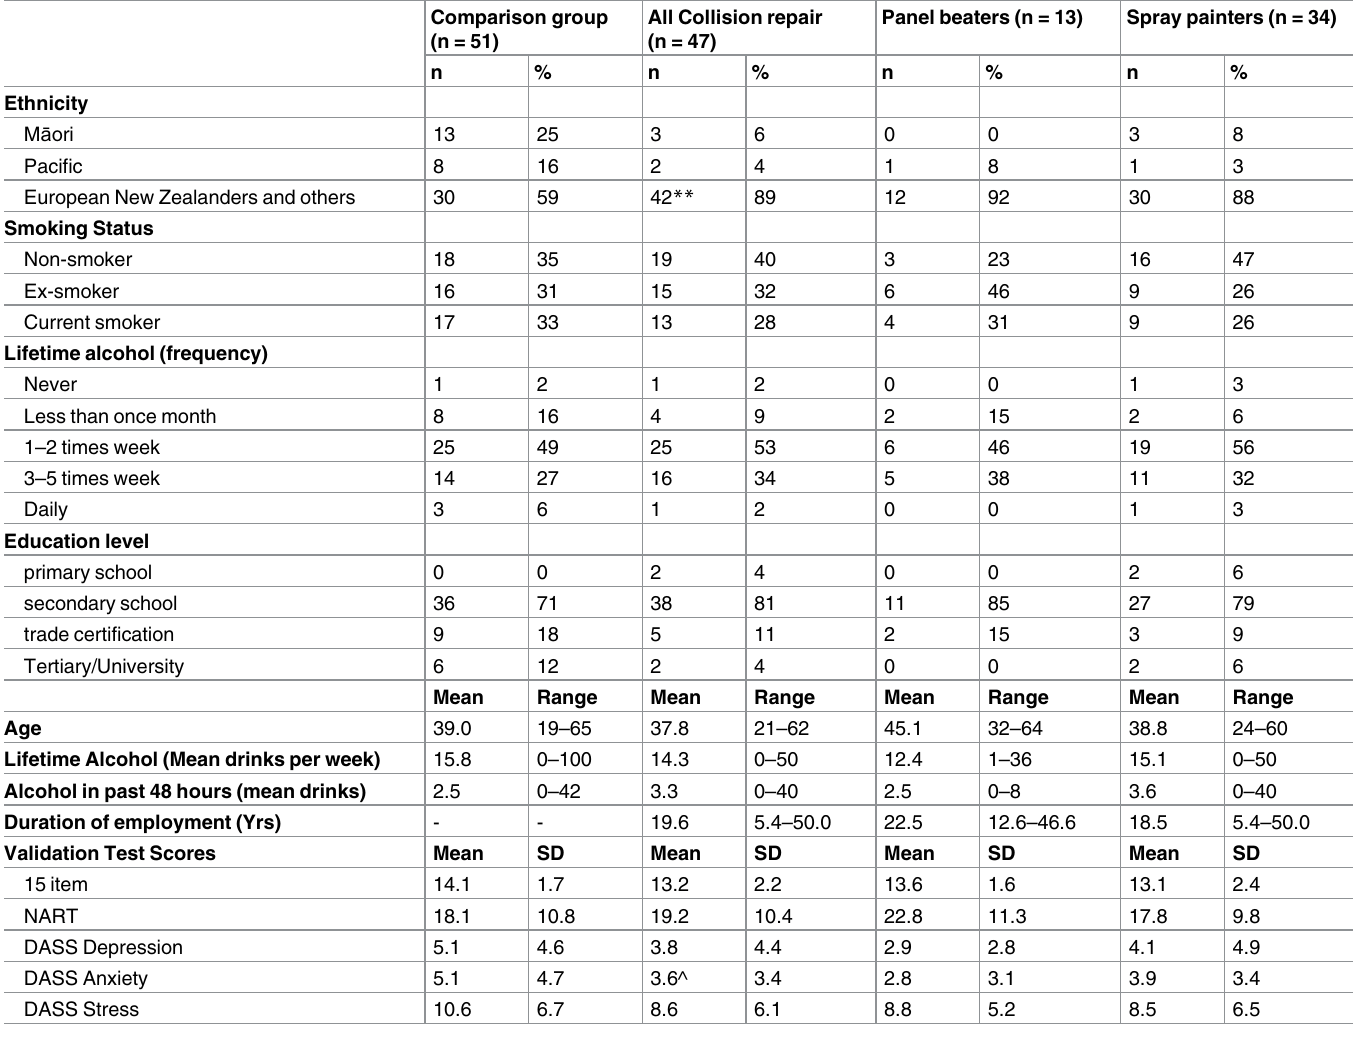
Table 1. Characteristics of study